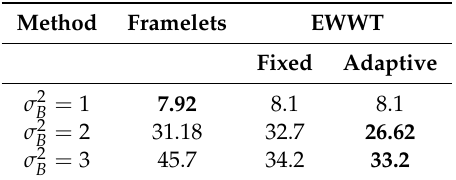
Figure 9. Example of the deconvolution performed on an image with a blur variance of σ 2 Note the artifacts present in the empirical curvelet approaches. Table 8. Average number of iteration until